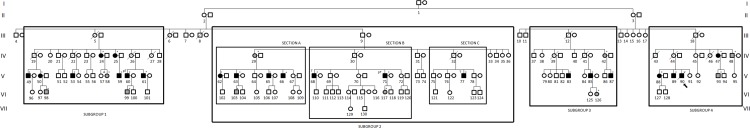
Generations I to VII are indicated in the image sides.Each individual of direct family linage is identified with a number. The index case is indicated by arrow (V-90); mutation carriers are represented with a +. Symptomatic patients are shown in black, asymptomatic patients are shown in gray, slashes indicate individuals who are deceased. T: transplanted; p-T: Pre-transplant stage.